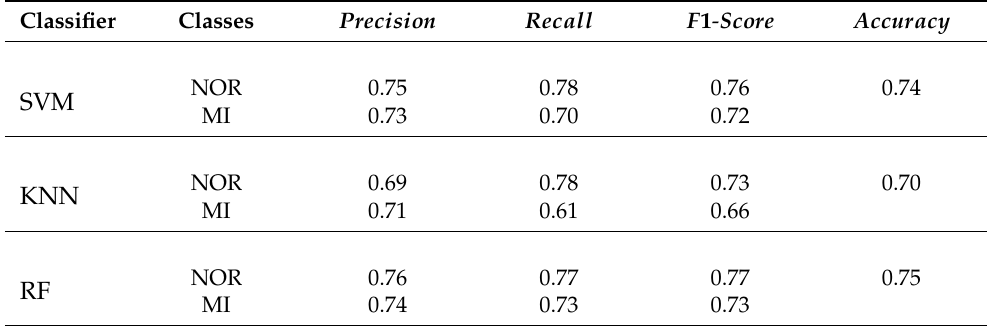
Table 4. Prediction performance comparison.